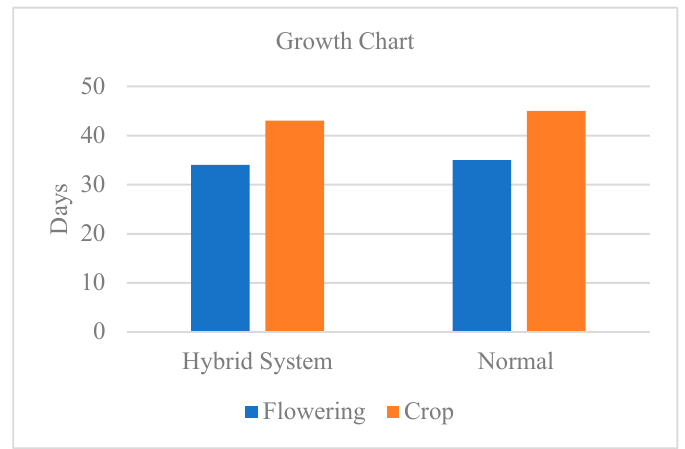
Figure 22. C omparison of strawberry productions. Figure 22. Comparison of strawberry productions.